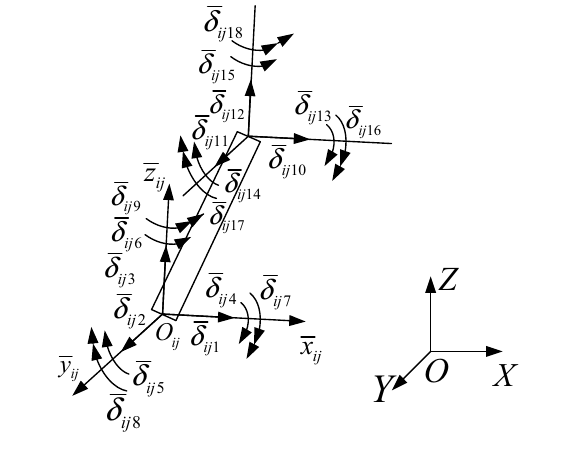
(b) Element generalized coordinates in base coordinate system Figure 7 Unit coordinate system transformation